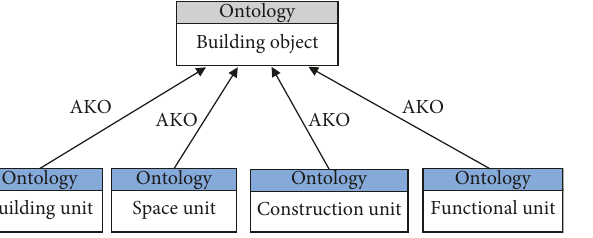
Figure 1: Building object